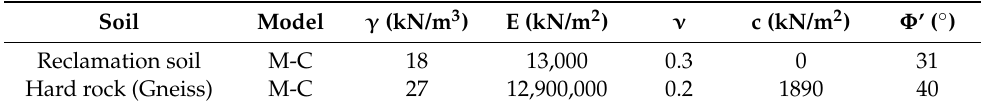
Table 1. Material parameters of ground.